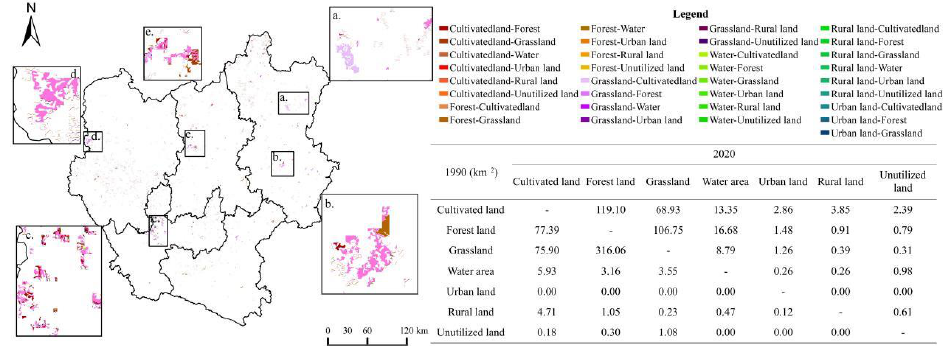
Figure 7. Ecosystem health improvement areas and their land use transfer matrix for 1990 – 2020.